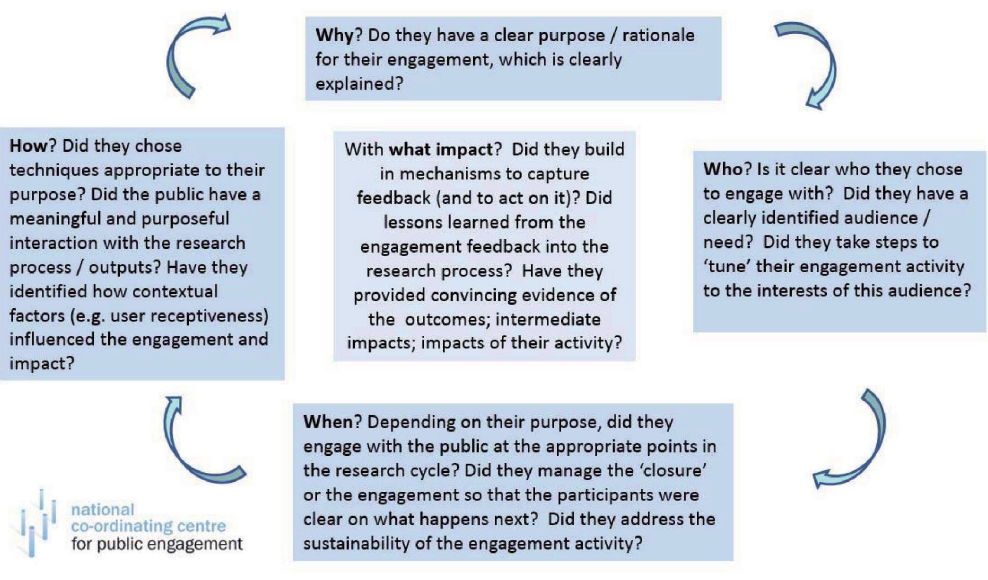
Figure 3: What does a ‘quality’ engagement process look like?